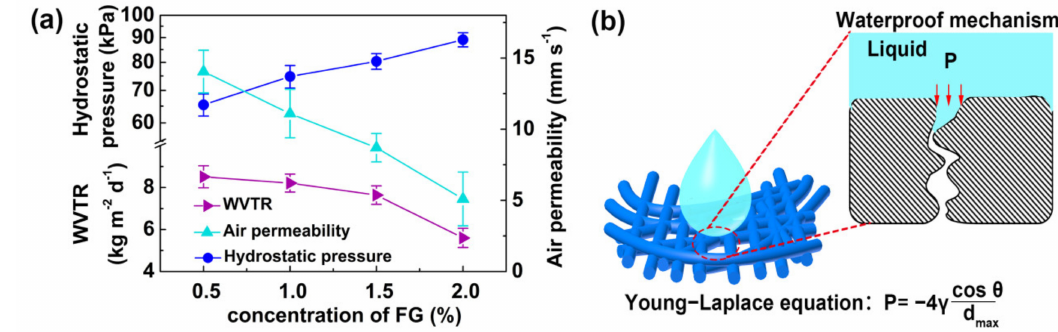
Figure 4. ( a ) Hydrostatic pressure, WVTR, and air permeability of the PU / FPU / TPU-50 / FG WB fabrics at di ff erent FG concentrations. ( b ) Waterproof mechanism based on the Young − Laplace